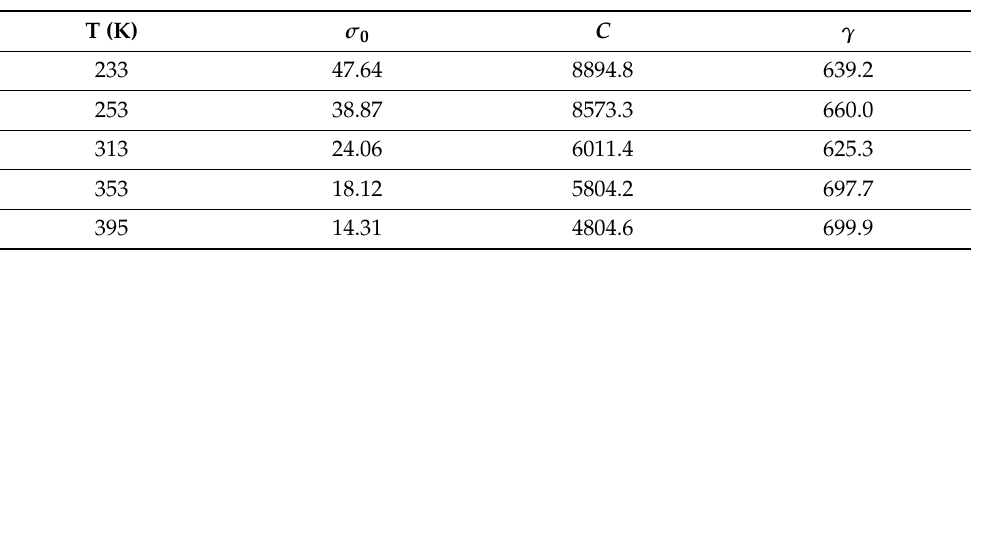
Figure 4. FO-WLP and the schematic of critical mesh size.